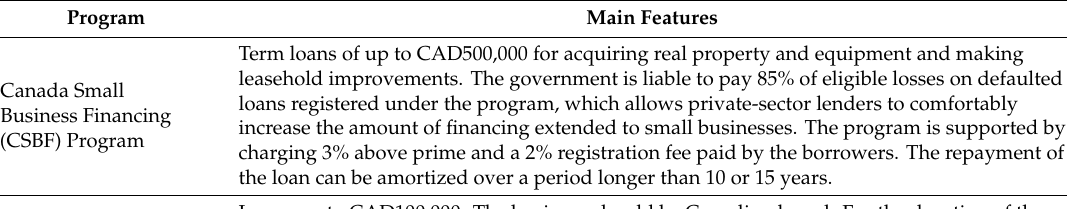
Table A2. Major government